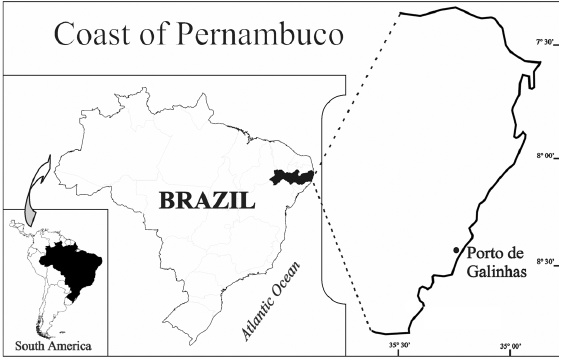
Fig. 1- Geographic localization of Porto de Galinhas beach in the coast of Pernambuco State,